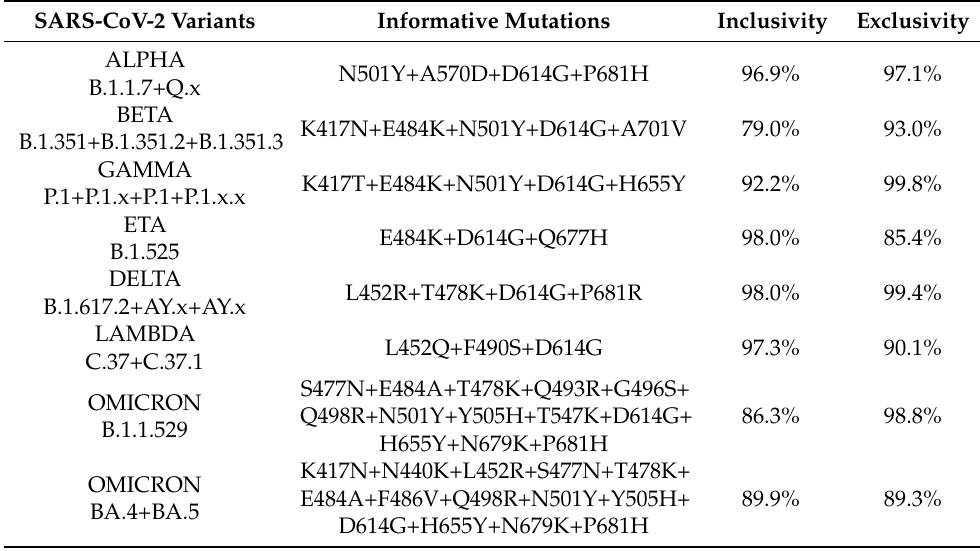
Table 1. Informative amino acid mutations and degree of in silico specificity of the S-gene 921 bp fragment (inclusiveness and exclusiveness) for variant identification.